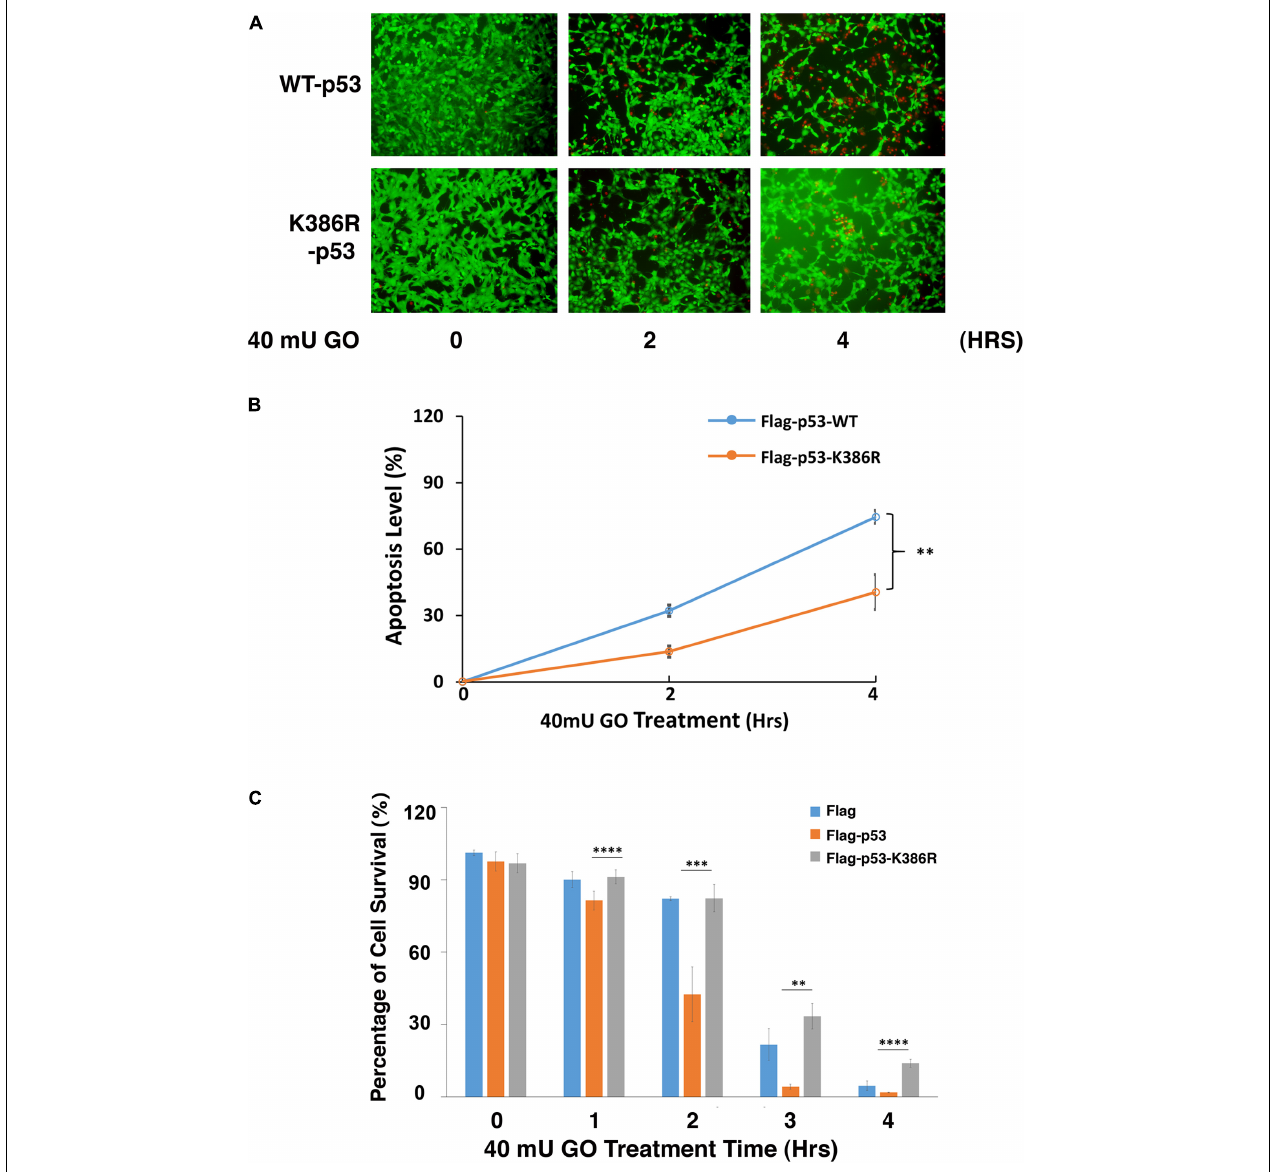
FIGURE 5 | Desumoylation of p53 protects lens epithelial cells from oxidative stress-induced apoptosis. p53-KO α TN4-1 cells were transfected with Flag, Flag-p53-WT, or Flag-p53-K386R as indicated. (A) Forty-eight hours after transfection, Live/Dead Viability/Cytotoxicity assay was conducted to analyze cell apoptosis under 40 mU GO treatment for 0 to 4 h. (B) The live/dead cells in panel (A) were quantified from three different experiments. (C) The cellTiter-Glo R (cid:13) luminescent cell viability assay was conducted to analyze cell apoptosis under 40 mU GO treatment for 0 to 4 h. All experiments were repeated three times. Error bar represents standard deviation, N = 3. ∗∗ p < 0.01, ∗∗∗ p < 0.005, ∗∗∗∗ p <